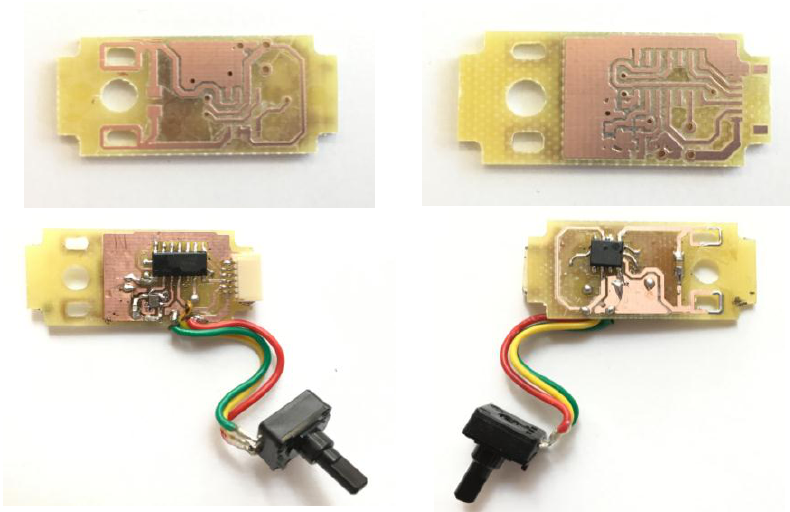
Figure 8. Prototype of the manufactured PCB. It has the precise size to fit inside the servomotor case.